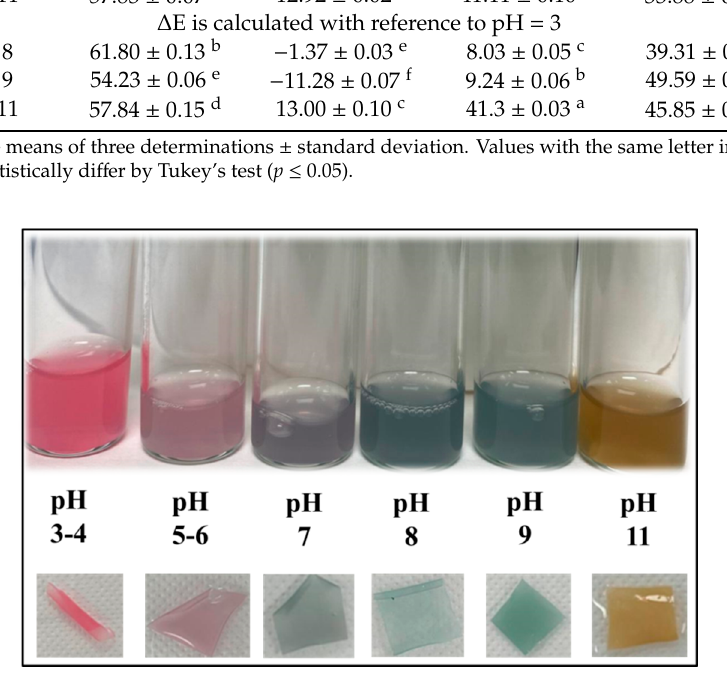
Figure 13. Digital images for the solutions ( top ) and NCFs ( bottom ) at different pH values.